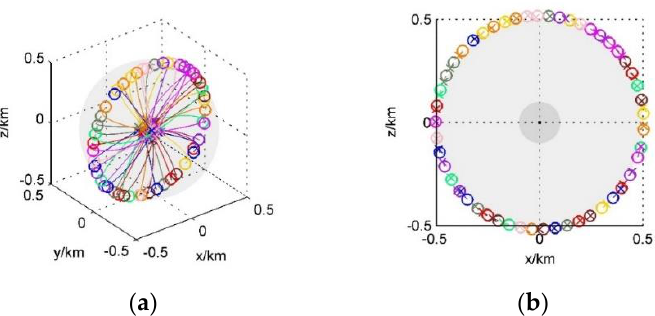
Figure 12. The in-plane circle formation ( 0.5km, 5km r = = − ). ( a ) Relative motion trajectory in 0-